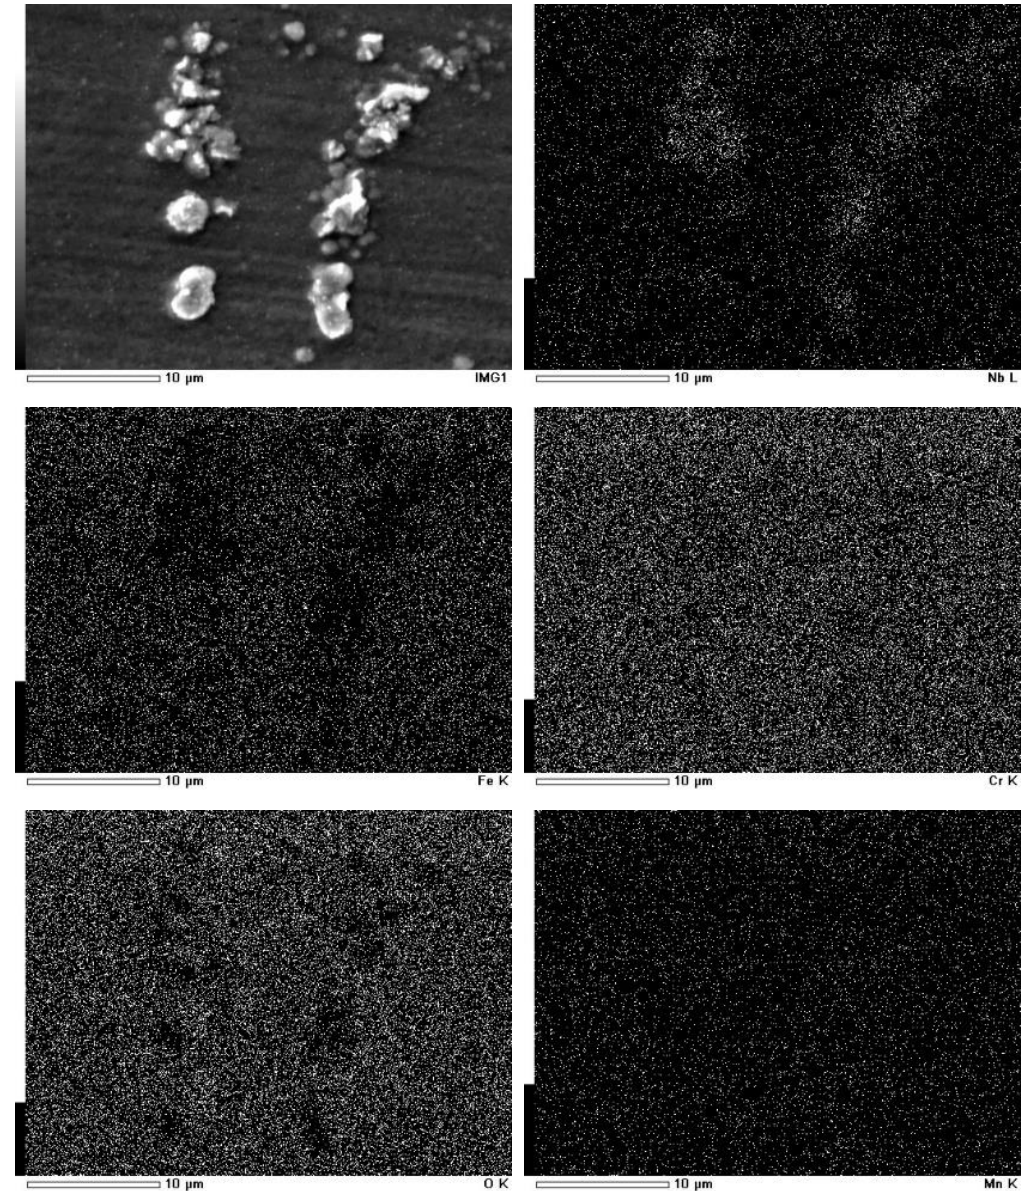
Figure 8. Element distribution of surface oxides on TP347HFG at 700 °C after 168 h.